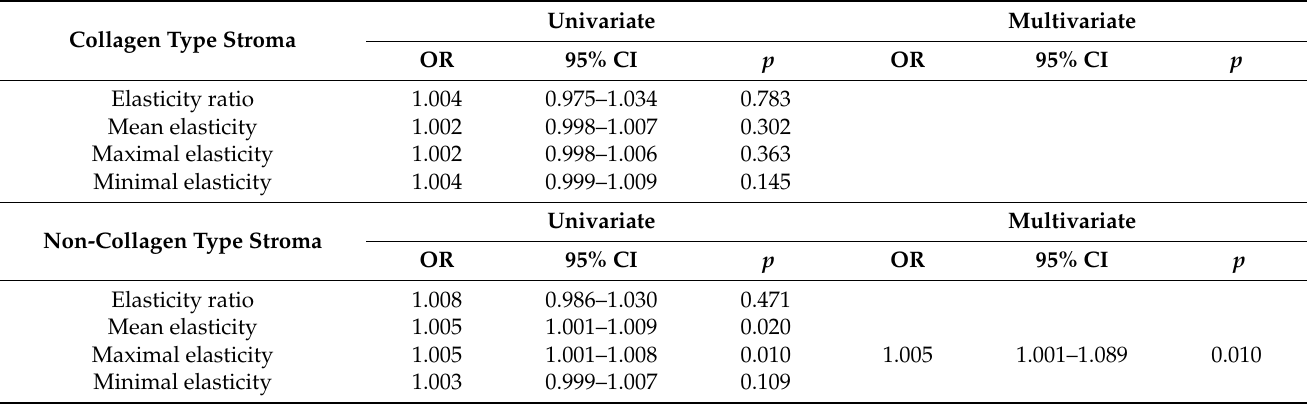
Table A4. Correlation between YAP1 positivity and tumor stiffness based on the stroma type of